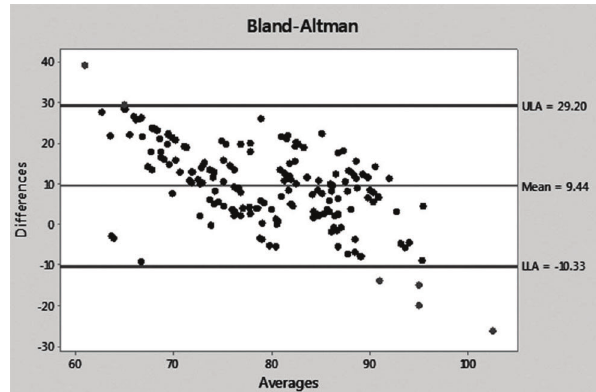
Figure 8 - Bland-Altman graph showing the distribution of the individual average points dispersed around the mean line but concentrated between the ULA and LLA lines; a single case was above the ULA, while four were below the